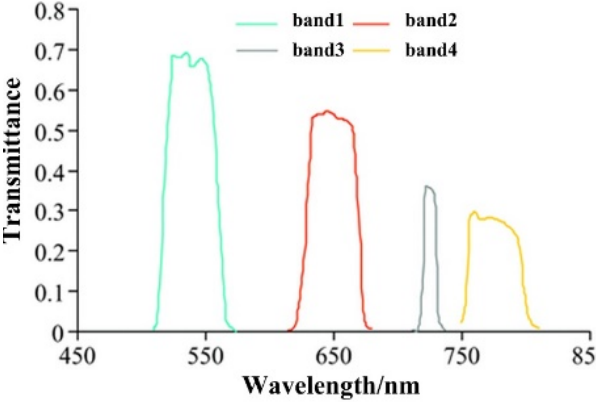
Figure 3. Sequoia sensor spectral response function.